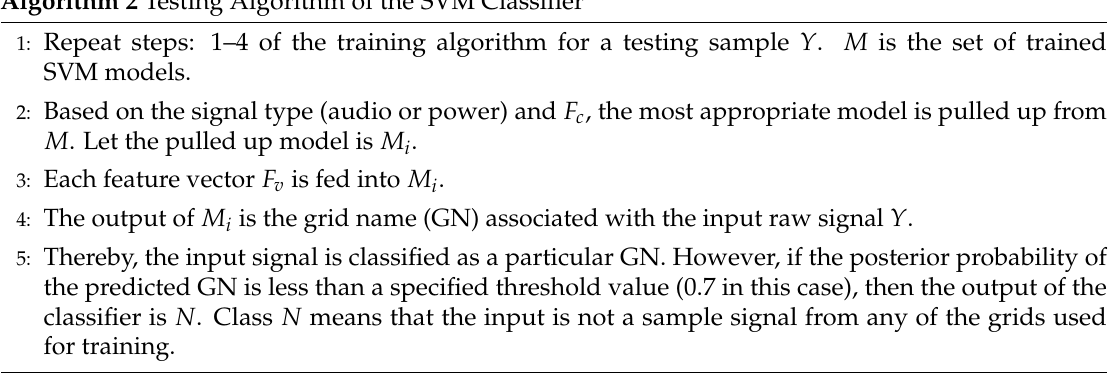
Algorithm 2 Testing Algorithm of the SVM Classifier